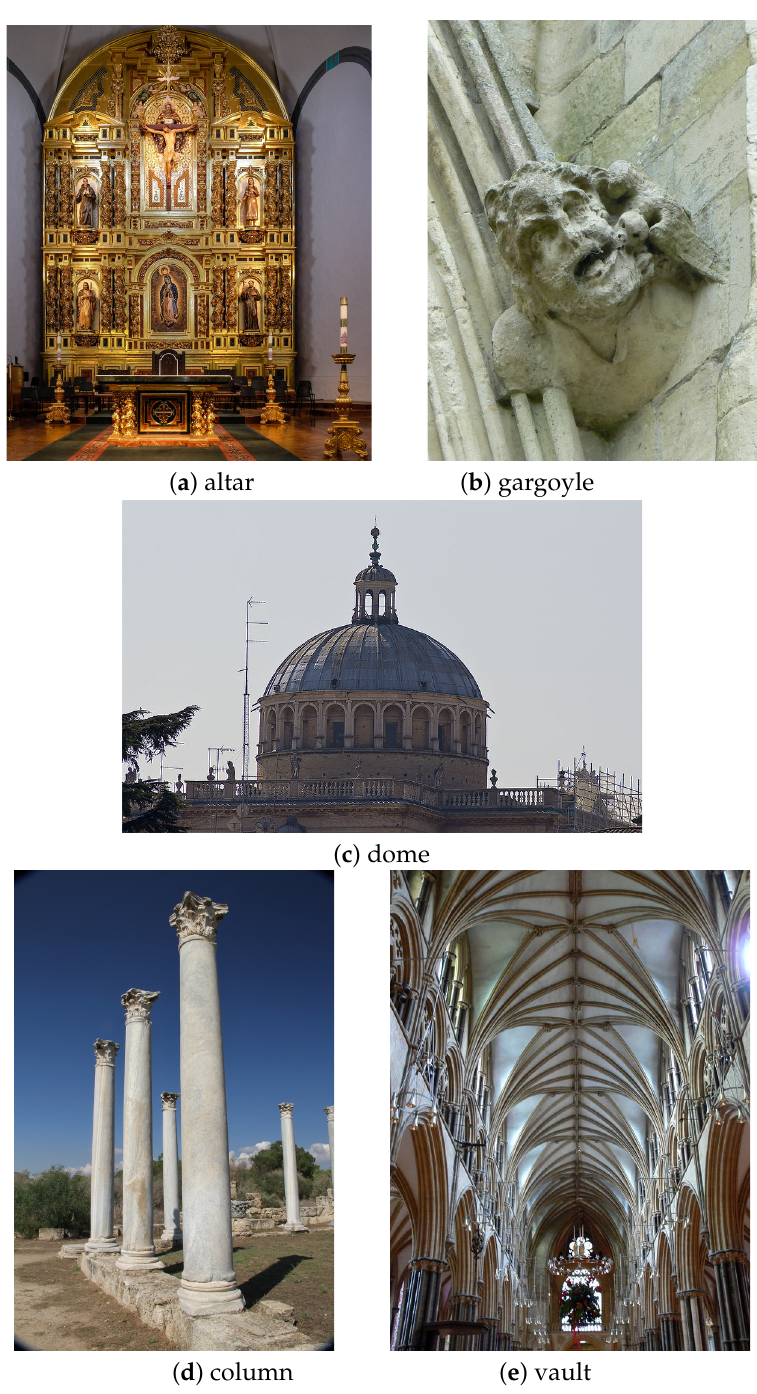
Figure 1. Examples of images used for each of the five classes, in particular: ( a ) the altar, ( b ) the gargoyle, ( c ) the outer dome, ( d ) the column, and ( e ) the